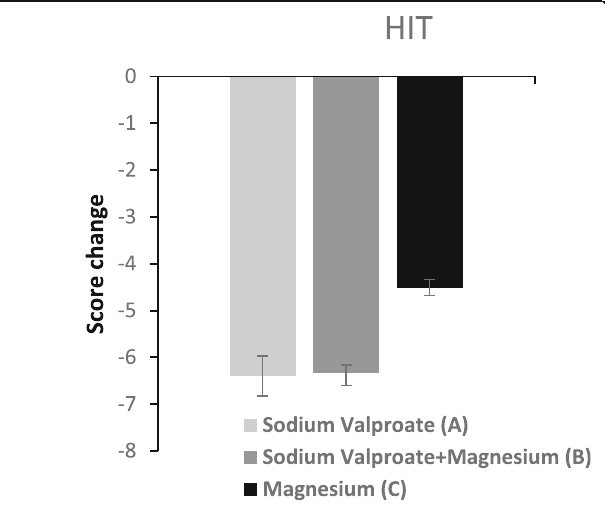
Fig. 4 Comparison of MIDAS and HIT-6 score change between three treatment groups. MIDAS change, P value: (A Vs B = 0.023, A Vs C = 0.001, B Vs C < 0.001). HIT change, P value: (A Vs B = 0.999, A Vs C < 0.001, B Vs C <